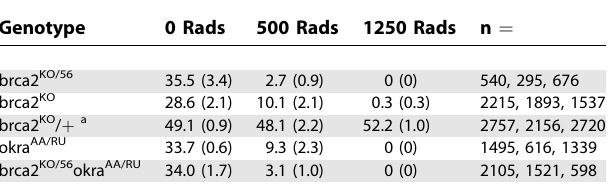
Table 2. Methyl Methanesulfonate Sensitivity of brca2 Mutants